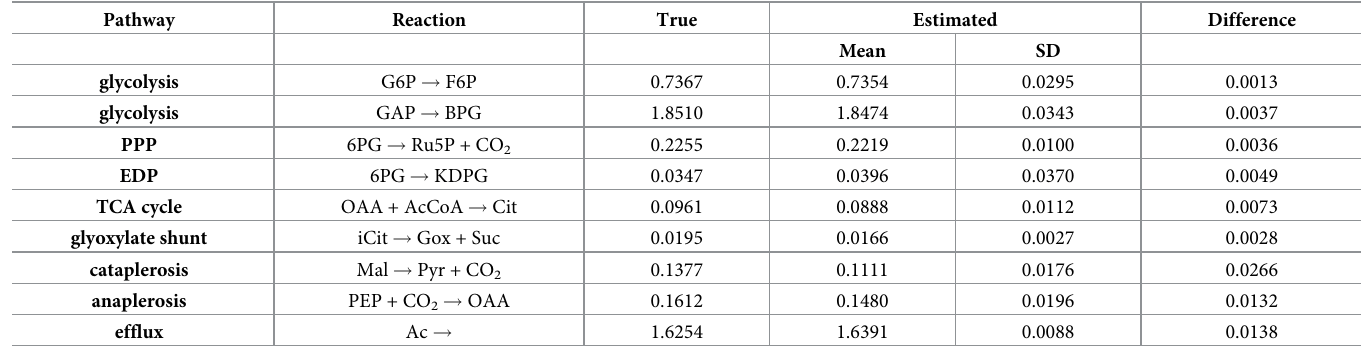
Table 2. True and estimated flux values are compared for a subset of reactions of the E . coli central carbon metabolism network. The difference is calculated between the true and estimated fluxes. Clearly, eiFlux accurately estimates the fluxes from a simulated set of measurements perturbed by simulated measurement error. Abbrevia- tions: pentose phosphate pathway (PPP), Entner-Doudoroff pathway (EDP), tricarboxylic acid (TCA), glucose 6-phosphate (G6P), fructose 6-phosphate (F6P), glyceralde- hyde 3-phosphate (GAP), 1,3-bisphosphoglycerate (BPG), 6-phosphogluconate (6PG), 2-keto-3-deoxy-6-phosphogluconate (KDPG), oxaloacetate (OAA),